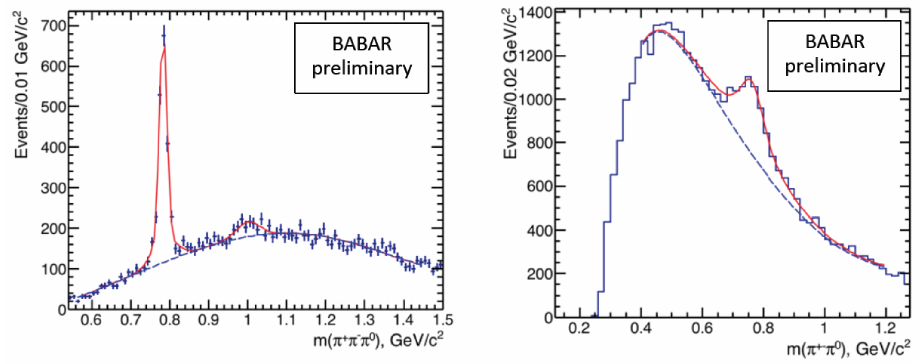
Figure 11. The dominant intermediate resonance structure observed in e + e − → π + π − π 0 π 0 η events: peaks at the (left) ω and φ → π + π − π 0 and (right) ρ ± → π ± π 0